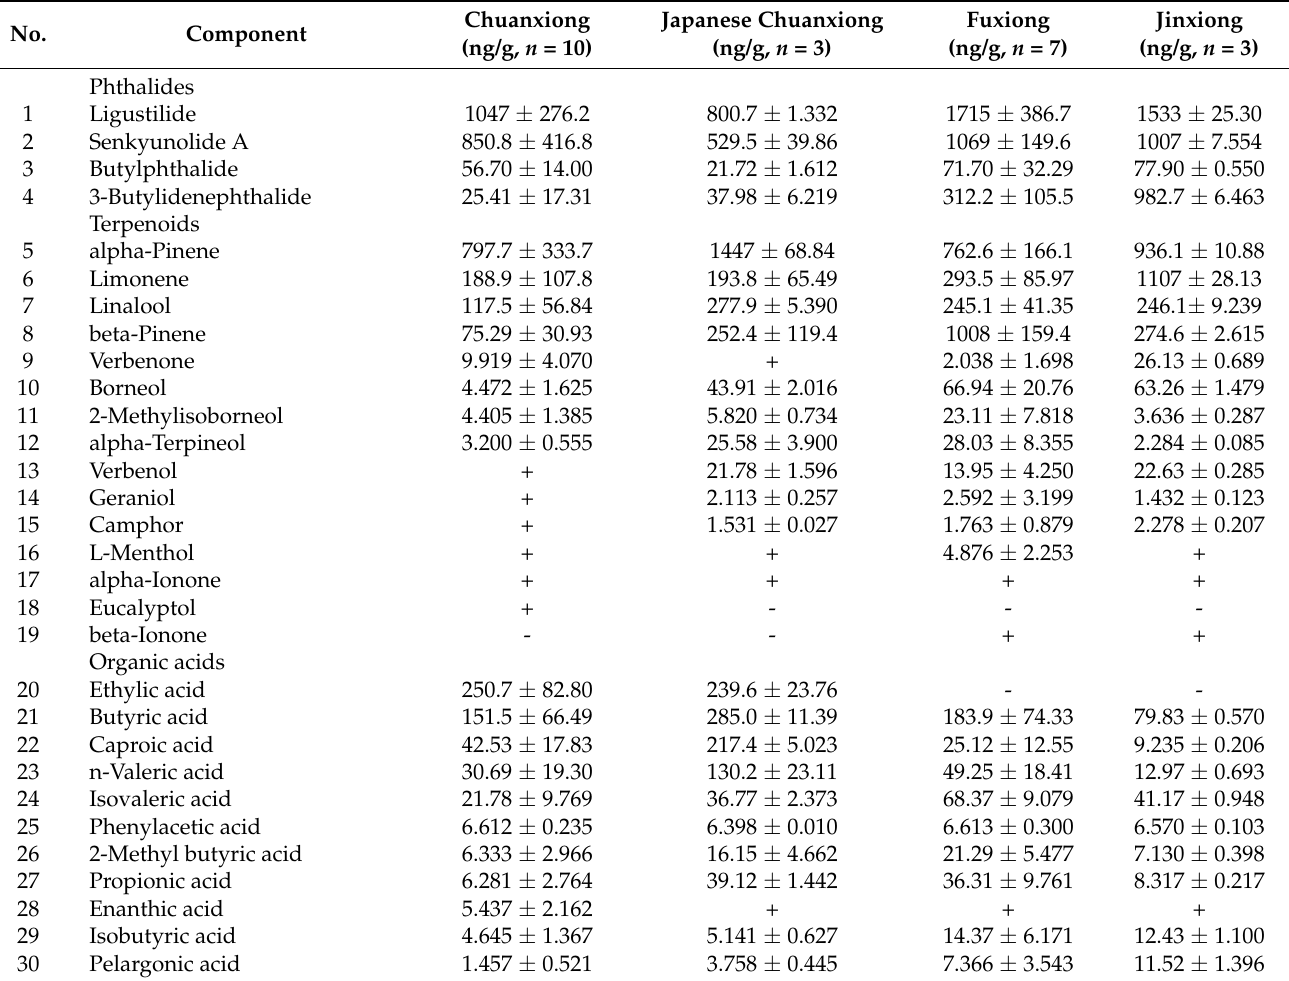
Table 2. The names and contents of compounds in the volatile gas of the four